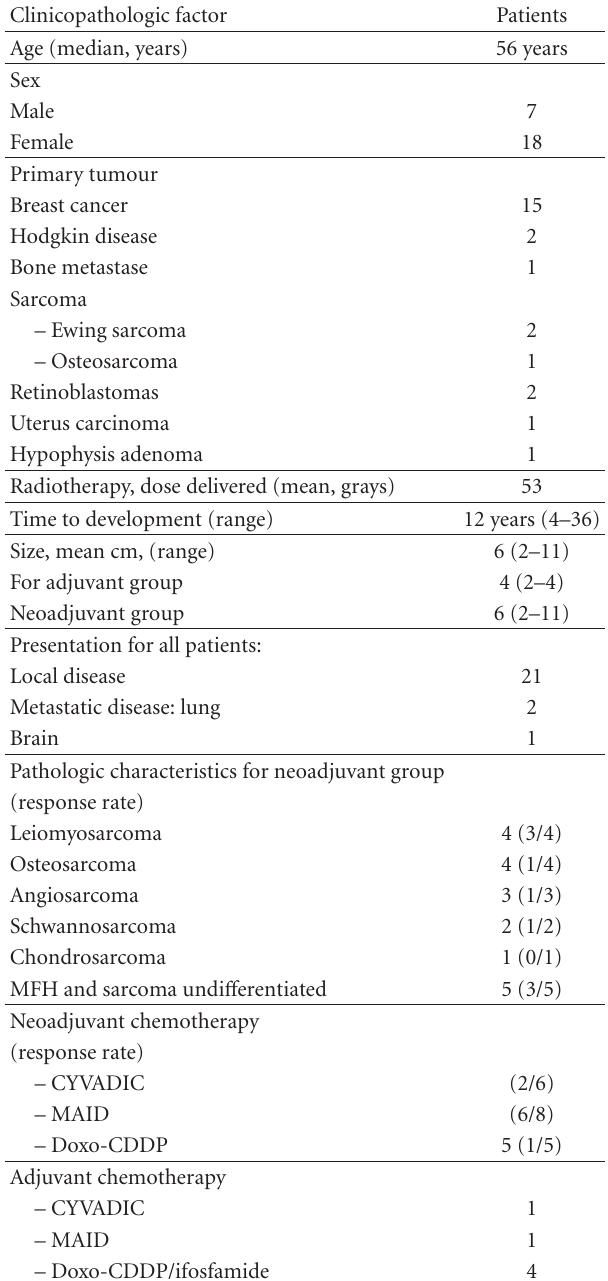
Table 1: Characteristics of patients in neoadjuvant group.